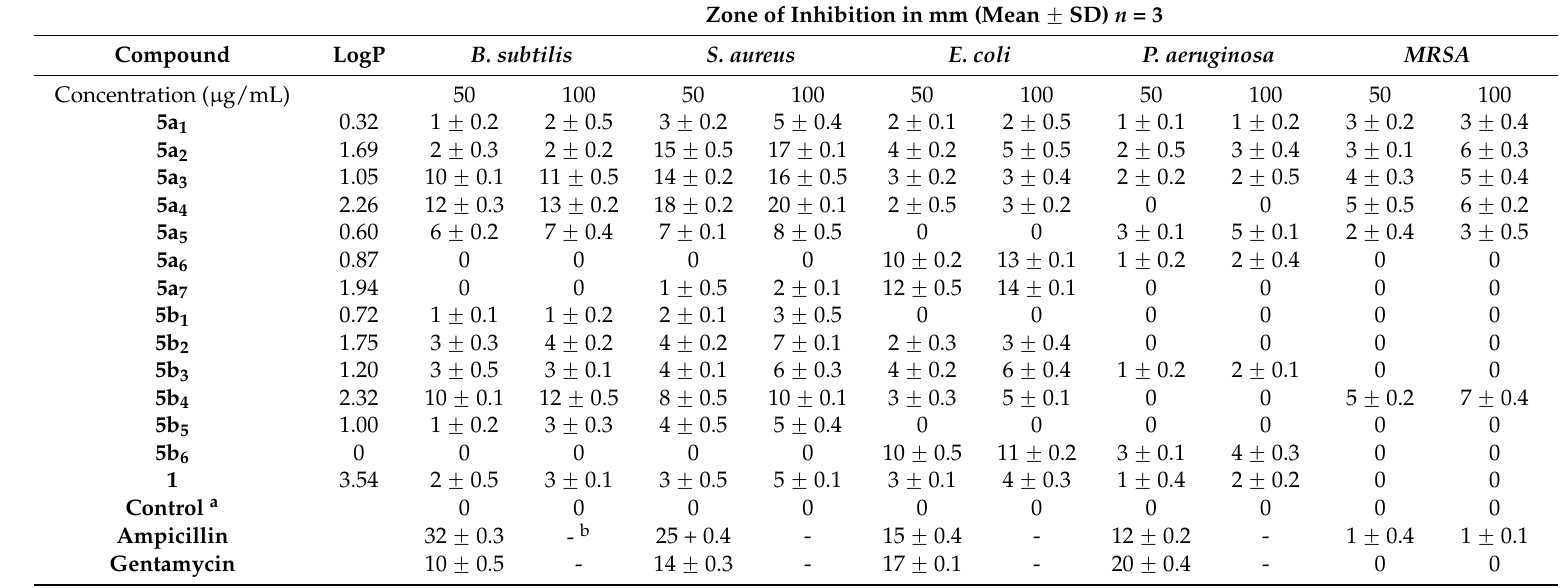
Table 1. Antibacterial activities of the synthesized compounds determined by the agar diffusion